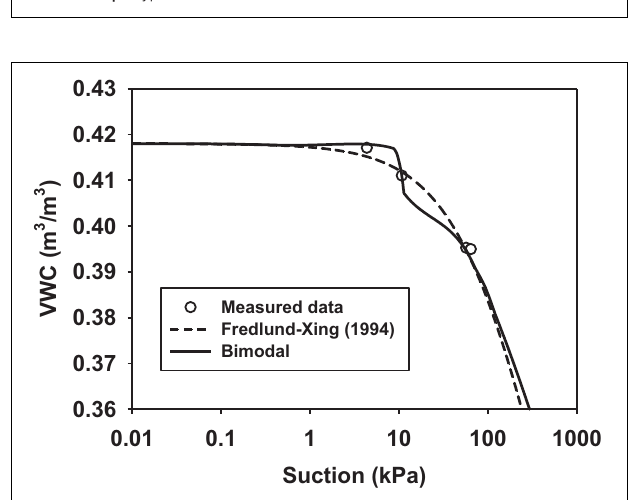
FIGURE 2 | A typical bimodal SWCC.